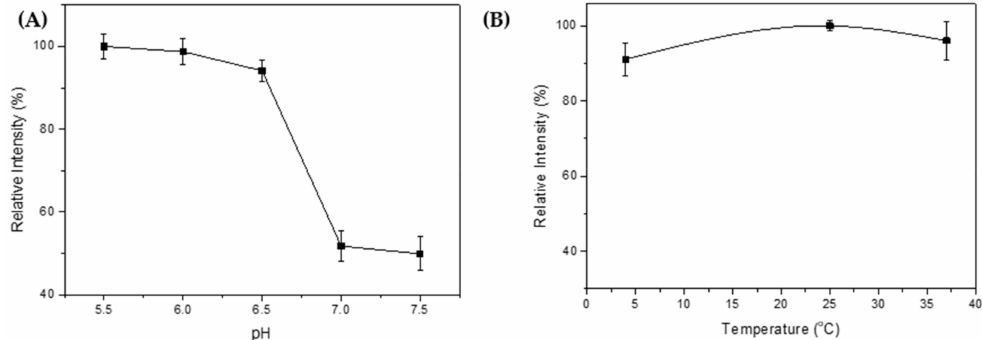
Figure 3. ( A ) E ff ect of pH on intein self-cleavage, ( B ) E ff ect of temperature on intein self-cleavage, where the relative intensity was calculated by dividing the color intensity by the highest color